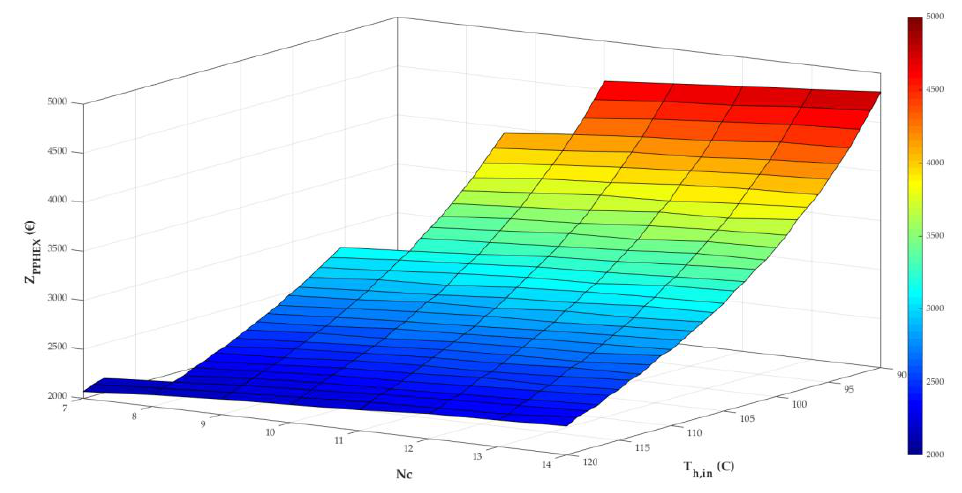
Figure 9. Heat exchanger investment cost. The variation of the main exergoeconomic costs as function of Nc and 𝑇 ℎ,𝑖𝑛 is illus- trated in Figure 10. The exergoeconomic cost of electricity, 𝐶 𝑒𝑙 , calculated in first term of Equation (21), is caused by electricity consumption of pumps during heating period. It dramatically increases as the geothermal fluid temperature grows because the pressure drops, and the deep well rises, while it presents a low variation with Nc, as depicted in Figure 10a. For Nc fixed to its maximum value (14), the yearly exergetic cost of electricity is equal to 213 €·y − 1 if 𝑇 ℎ,𝑖𝑛 is 90 °C, and 245 €/y if 𝑇 ℎ,𝑖𝑛 amounts to 120 °C, presenting a percentage variation of 13%. By fixing 𝑇 ℎ,𝑖𝑛 to 120 °C, the electricity exergoeconomic cost is equal to 255 €·y − 1 if Nc decreases to 7, showing a percentage variation of 4%. Figure 10b illustrates the yearly amortized cost of PPHEX. It reaches the highest values when the geothermal fluid temperature is lower than 96 °C; thus, in this condition, the exergoeco- nomic PPHEX cost is greater than 350 €·y − 1 . Nc determines a not very relevant influence